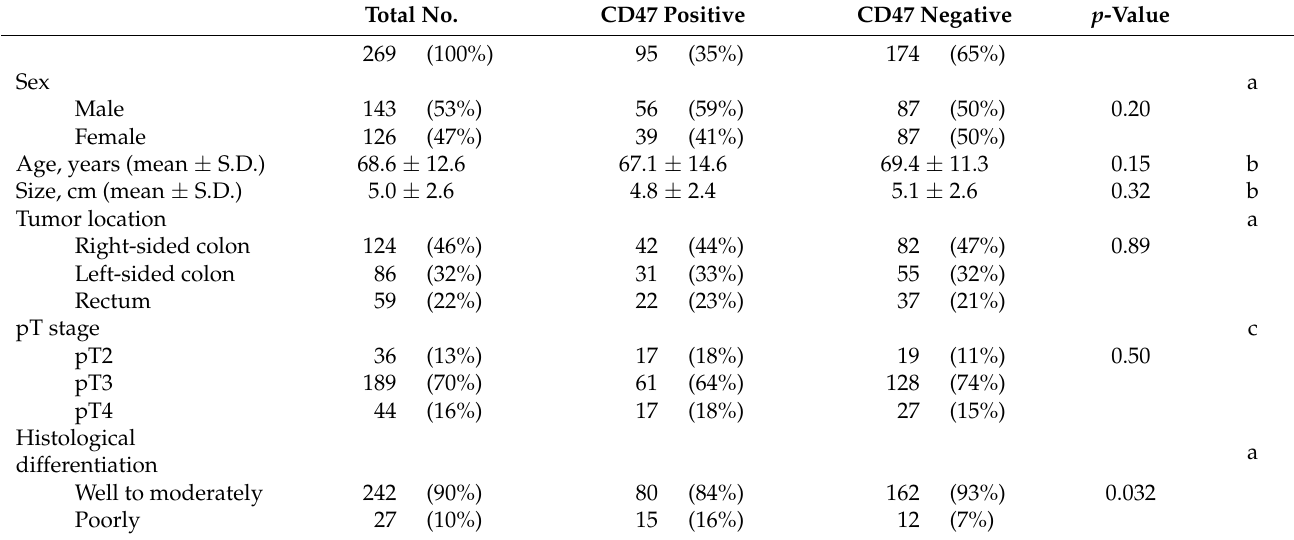
Table 1. Characteristics of colorectal carcinomas with or without CD47 expression. a, p -values were calculated by the Chi- square test for CD47 expression. b, t -test or c, Cochran–Armitage trend test was used to calculate p -values. The Bonferroni- corrected p -value for significance was p ≈ 0.0042 (0.05/12). Age, years (mean ±